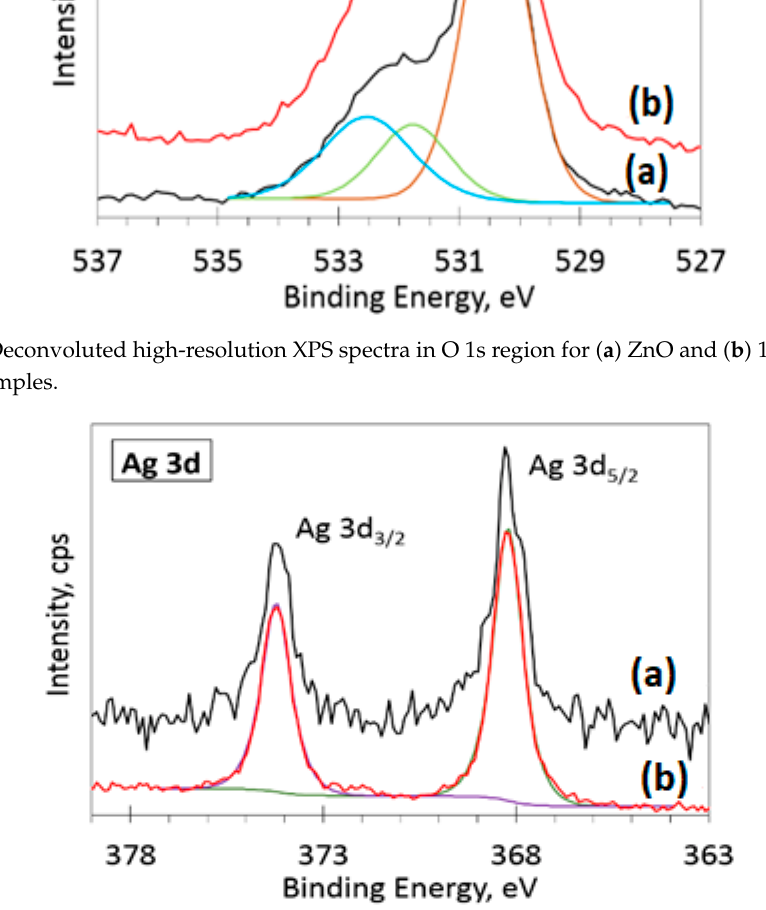
Figure 7. High-resolution XPS spectra for ( a ) 1% Ag-ZnO powder sample and ( b ) deconvoluted spectra for 10% sample.